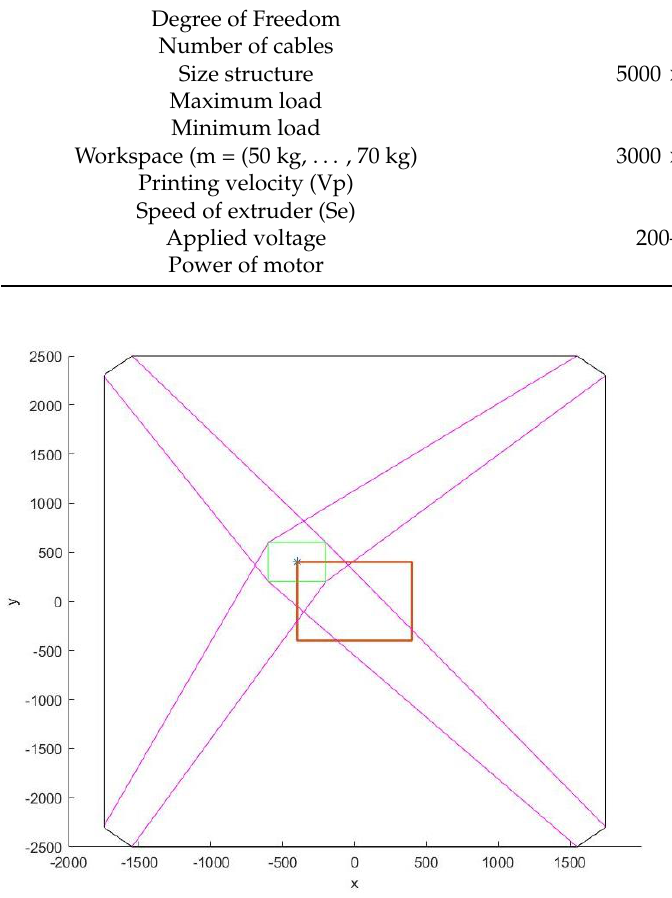
Figure 16. Square with side 800 mm trajectory in the XY plane, Z = 550 mm.